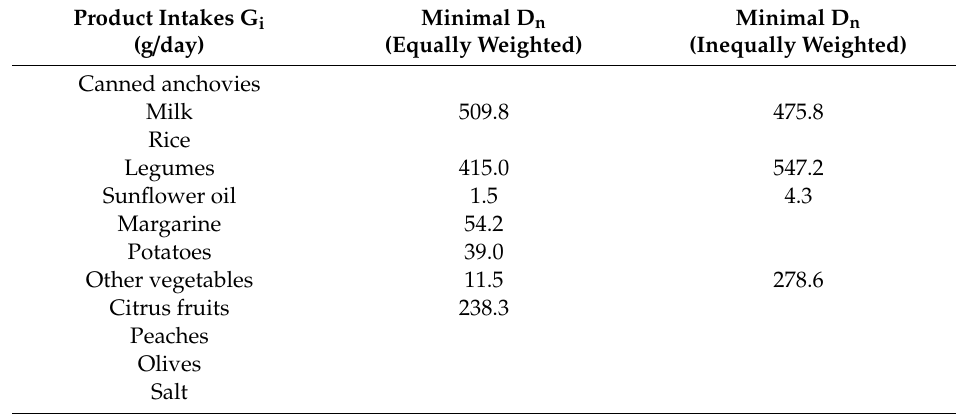
Table A2. Food intake (g / day) of four optimized diets without restrictions.